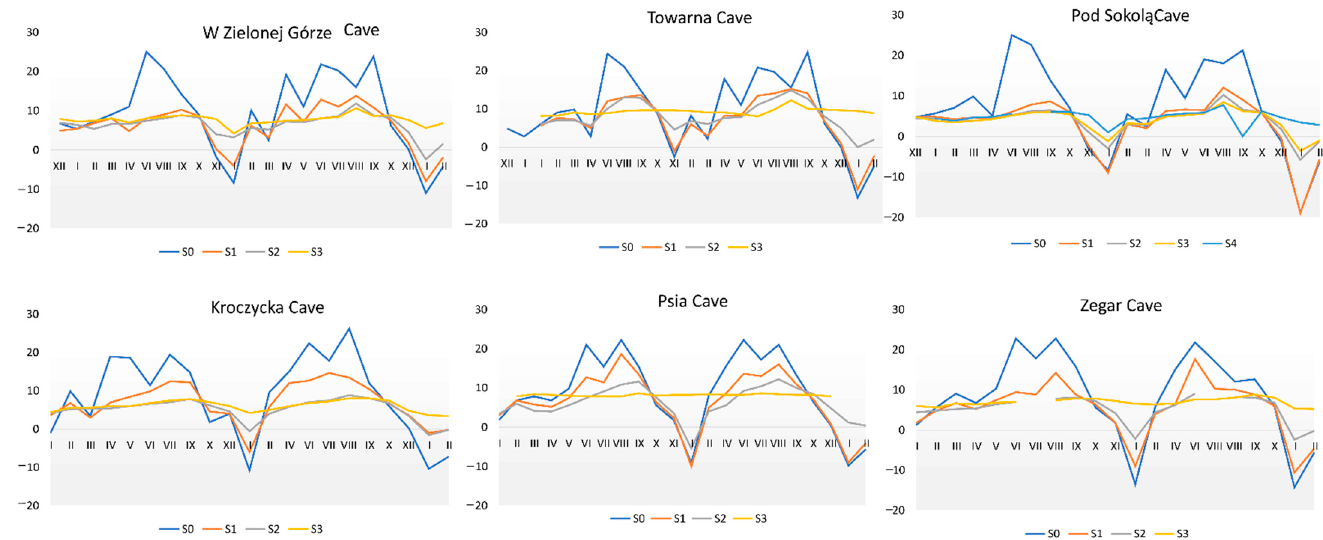
Figure 7. Temperature fluctuations at the measurement points in the studied caves.